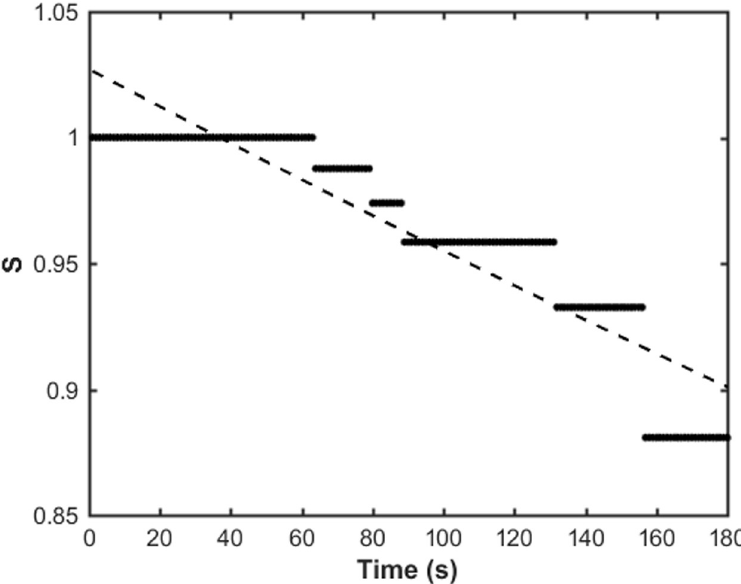
Fig 9. Example of the Kaplan-Meier estimate of nucleation time. The estimator data, S ( t ), for the filament are shown with black dots. The best fit exponential decay, e (cid:0) t = t nuc , is shown by the dashed line, from which a nucleation time t 1370 seconds was determined. The Kaplan-Meier analysis here was done on the filament shown in Fig 3C.